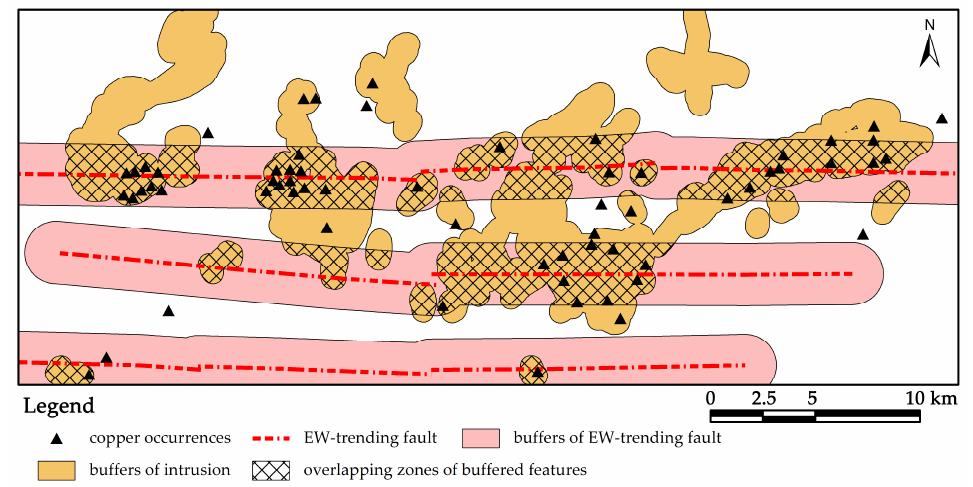
Figure 15. Graph of cumulative relative frequency concerning distance to ( a ) EW-trending faults; ( b ) NS-trending faults; ( c ) intersections of basement faults; ( d ) NE-trending faults; ( e ) NW-trending faults and ( f ) intersections of cover faults.